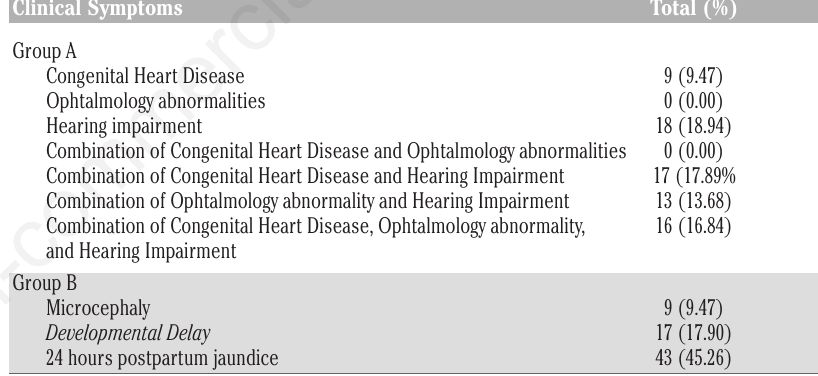
Table 2. Clinical Symptoms of Congenital Rubella Syndrome.